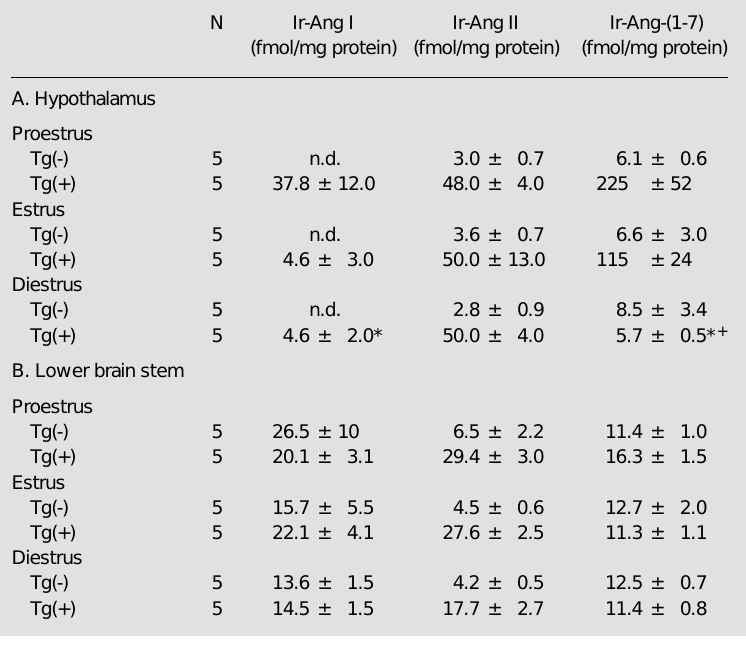
Figure 7 - Schematic diagram demonstrating the effects of estrogen on the renin-angio- tensin system. ACE, Angio- tensin converting enyme;